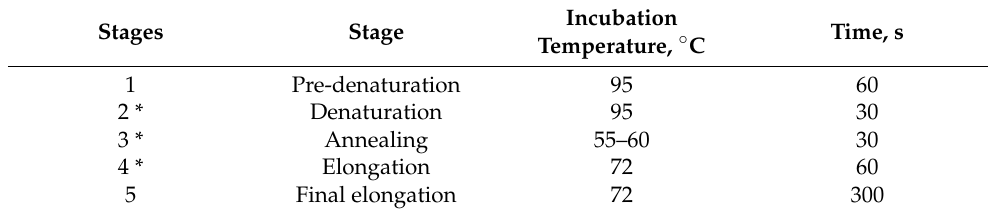
Table 2. Cycling parameters during amplification of variable